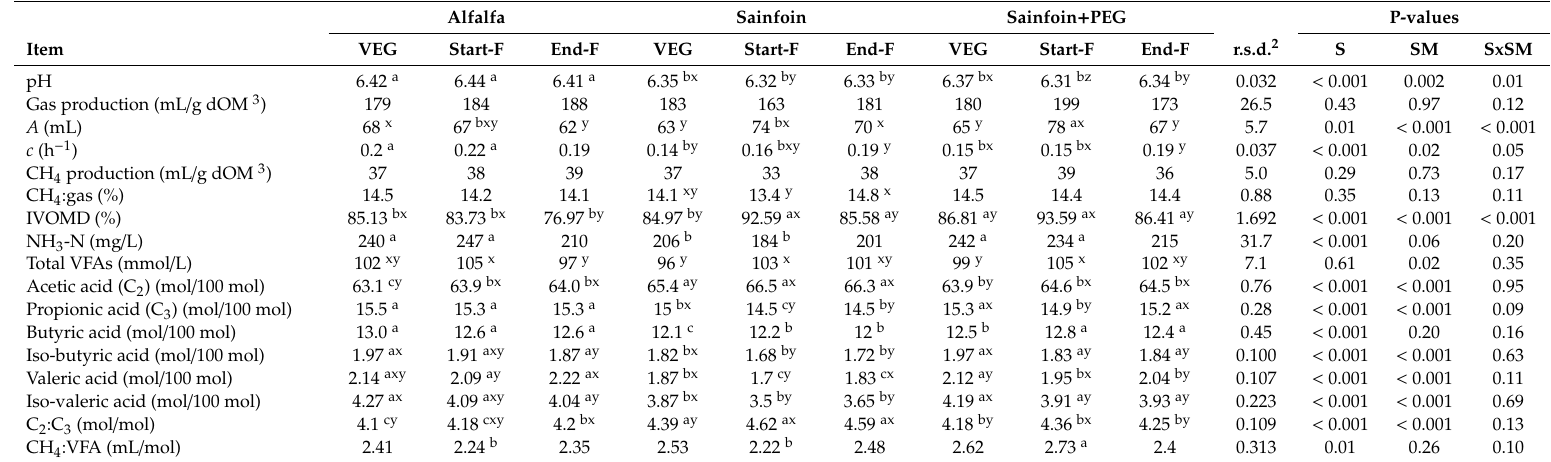
Table 2. E ff ect of the substrate (S) and the stage of maturity 1 (SM) on gas and methane production (CH 4 ), potential gas production ( A ), rate of gas production ( c ), in vitro organic matter degradability (IVOMD), ammonia (NH 3 -N), and volatile fatty acids (VFAs). Alfalfa Sainfoin Sainfoin + PEG P-values Item